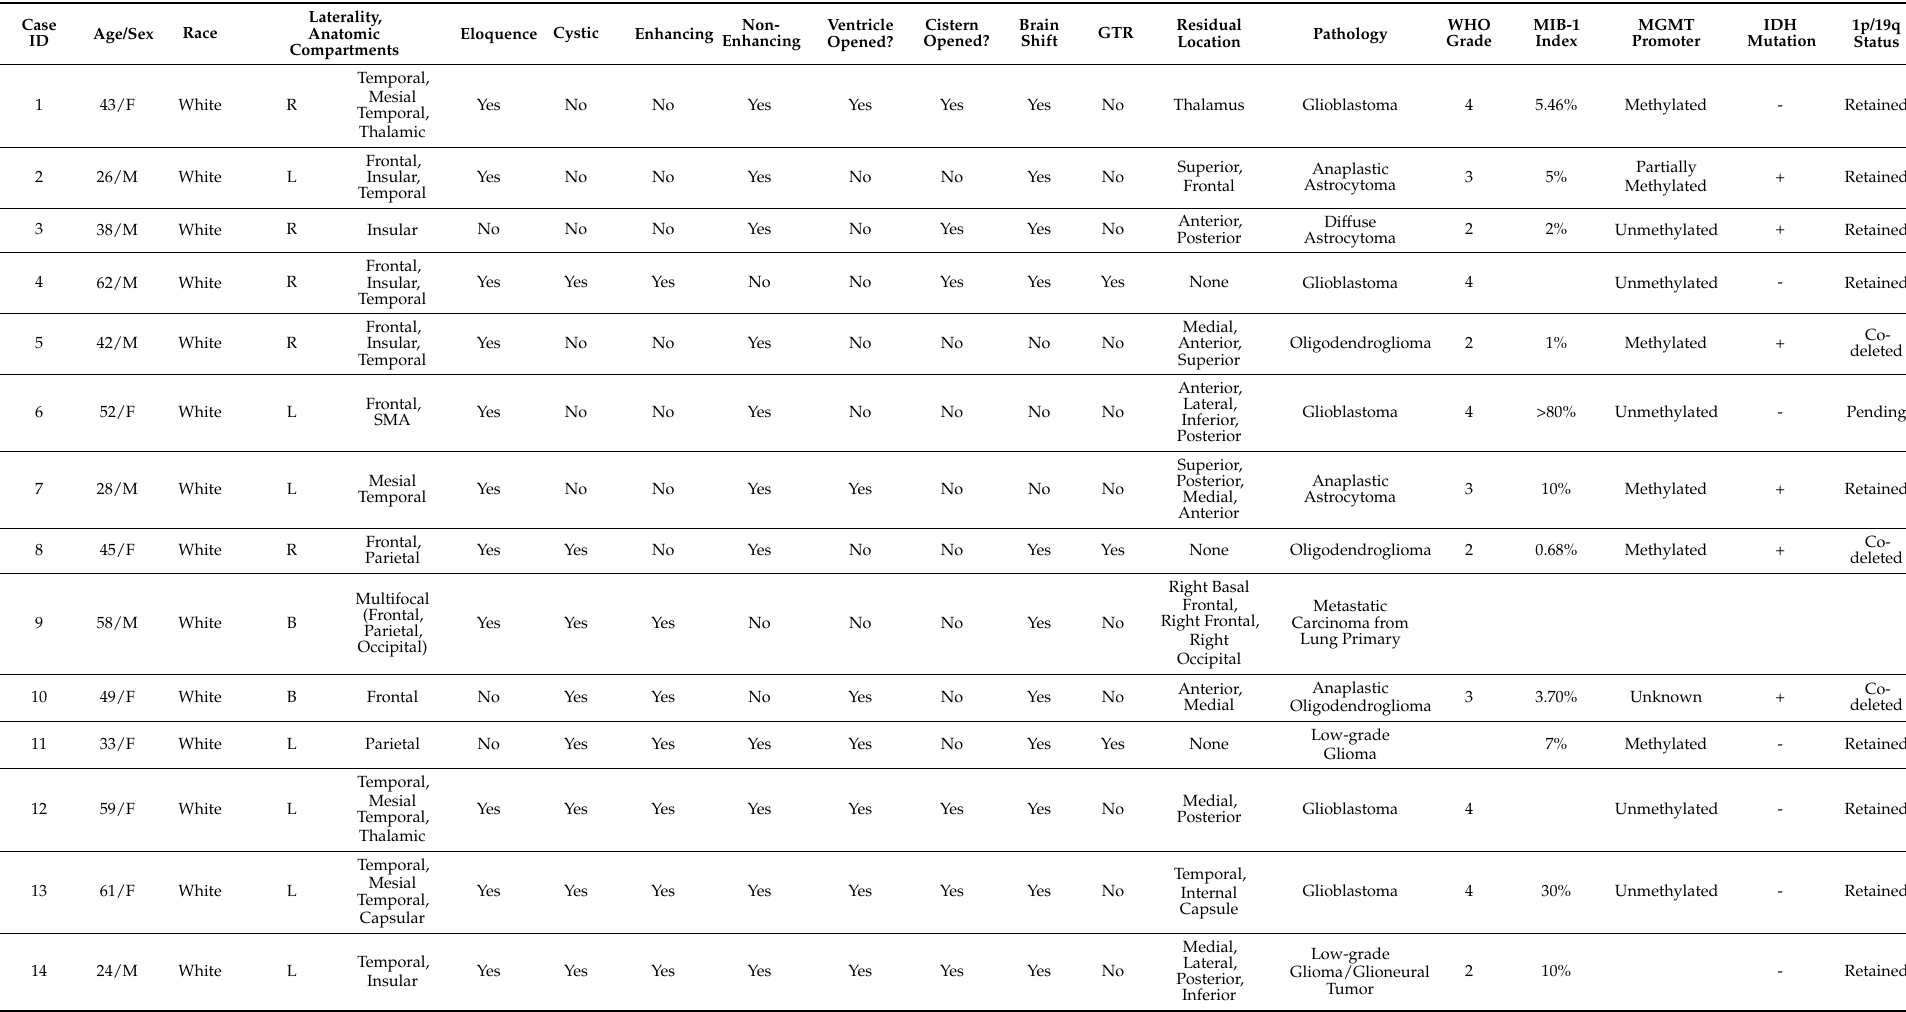
Table A2. Distribution of clinical and surgical descriptors and metadata for all cases (R: right, L: left, B: